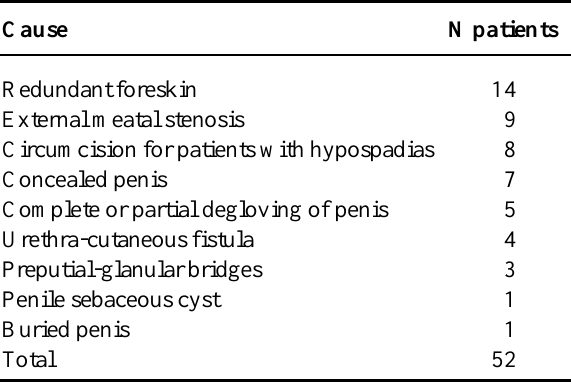
Table 1 – Causes of circumcision revision.